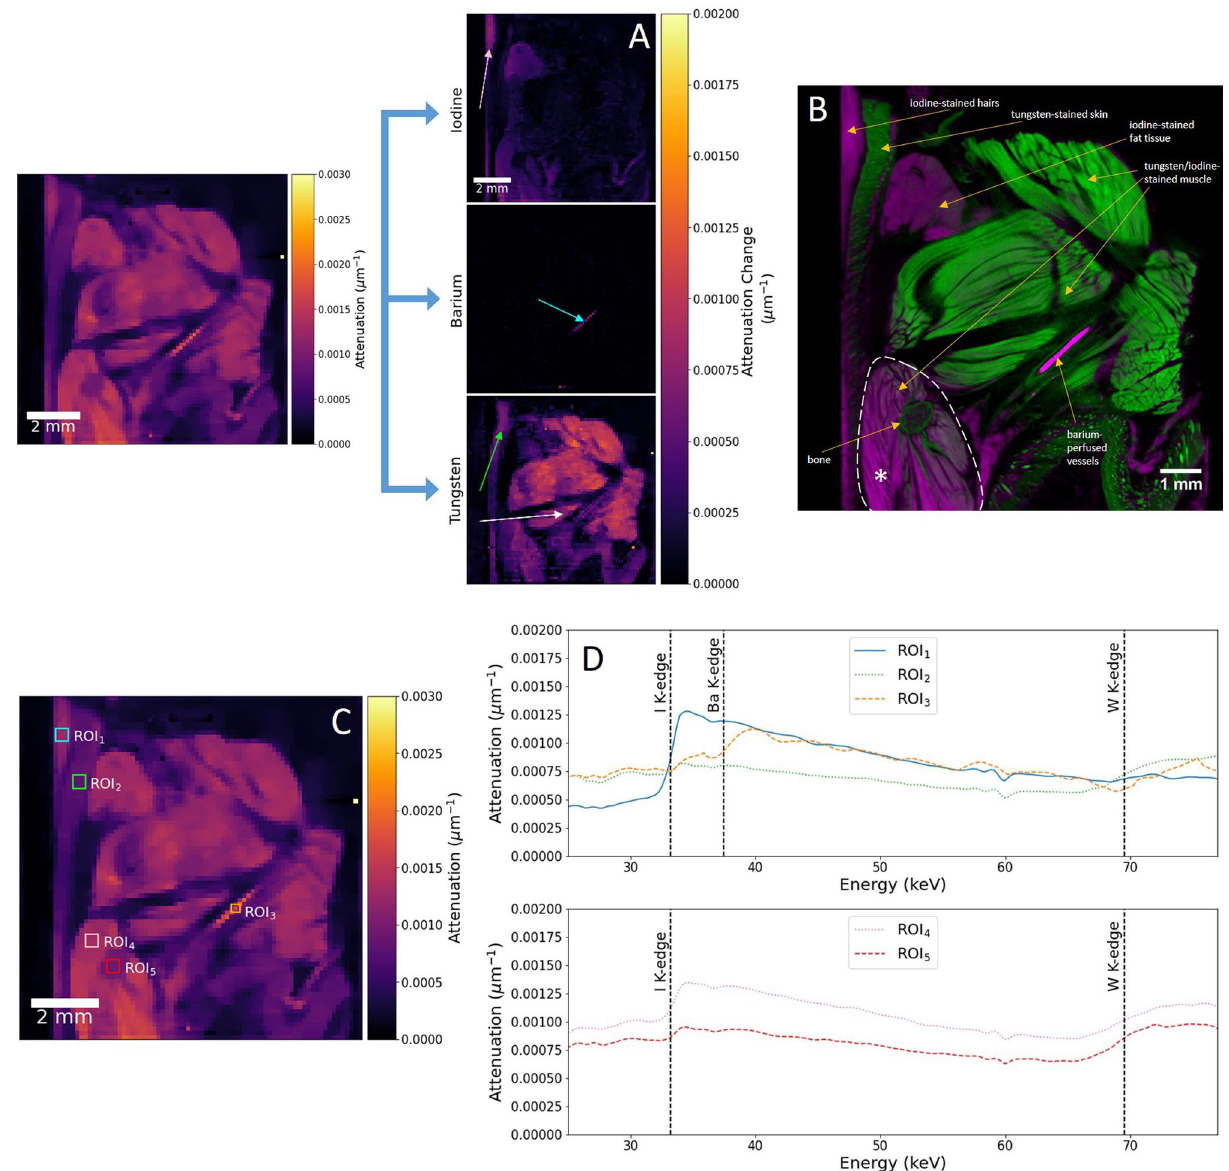
Figure 4. Spectral analysis for a triple-stained forelimb specimen. ( A ) Elemental difference maps shown for the hyperspectral image slice shown in the coronal plane (left). Colour bar for elemental difference maps is measured in terms of attenuation change, Δµ. Arrows are included to highlight distinct soft tissue regions stained by each chemical, confirmed as hair (pink), vasculature (blue), skin (green) and muscle (white). ( B ) Reconstructed cross-section from a high spatial resolution DECT scan of the mouse forelimb, following basis material decomposition. The image slice matches that shown in the hyperspectral dataset, following volume registration. Labels indicate regions containing tungsten and calcium (green), as well as those containing iodine and barium (magenta). DECT decomposition fails to fully segment all elements into distinct phases. The dashed region and asterisk highlight the area below the elbow joint where PTA did not fully stain. ( C ) Reconstructed cross-section slice in the coronal plane of the triple-stained mouse forelimb. ROIs are shown for five distinct regions of the specimen, to analyse average voxel spectra. All ROIs cover 3 × 3 pixels, apart from ROI 3 , which covers a 2 × 2 region. ( D ) Voxel spectra for the ROIs selected in ( C ). Known K-edge positions are overlaid, with ROIs 1, 2 and 3 matching the K-edges for iodine, barium and tungsten respectively (top). Two ROIs, 4 and 5, show the presence of both iodine and tungsten contrast agents